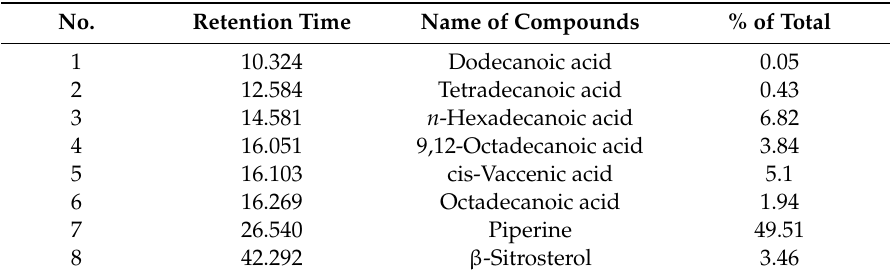
Table 4. Phytochemical compounds identified in P. ribesioides by using GC-MS. No.